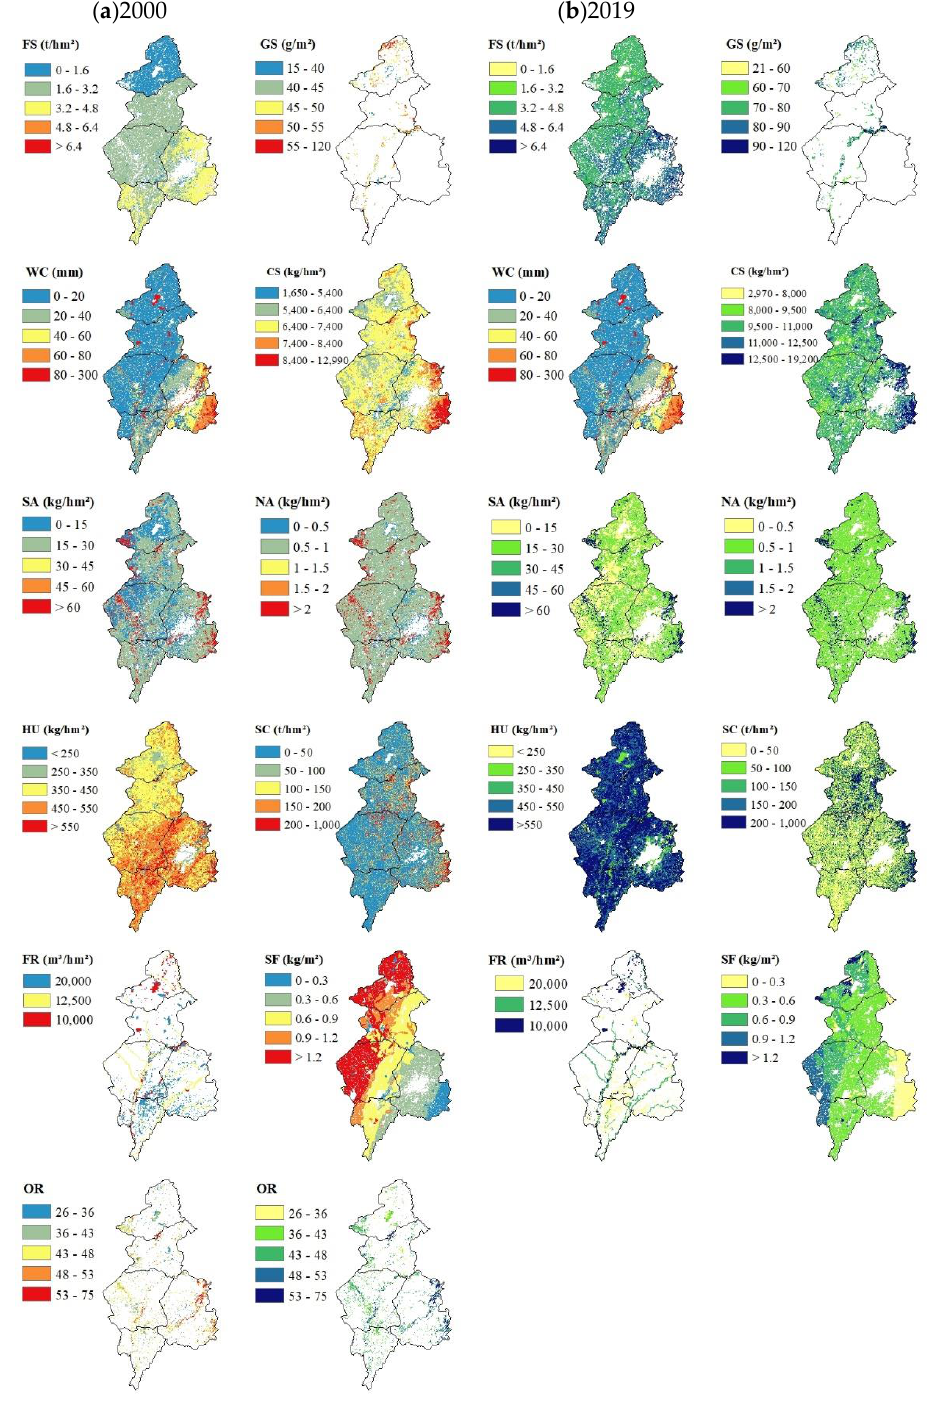
Figure 1. Spatial distribution of ES in Shenyang during ( a ) 2000 and ( b ) 2019, food supply (FS), grass supply (GS), water conservation (WC), carbon sequestration (CS), SO 2 absorption (SA), NO x absorption (NA), humidification (HU), soil conservation (SC), flood regulation (FR), soil fixation (SF), outdoor recreation